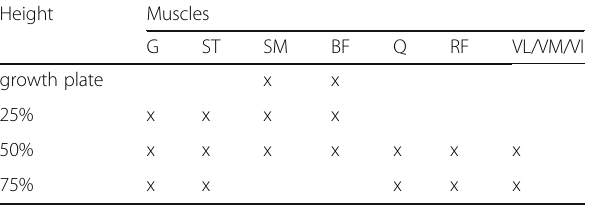
Table 2 Heights at which the cross-sectional areas of the muscles were measured from distal to proximal thigh. Empty fields indicate that the muscle was not identifiable